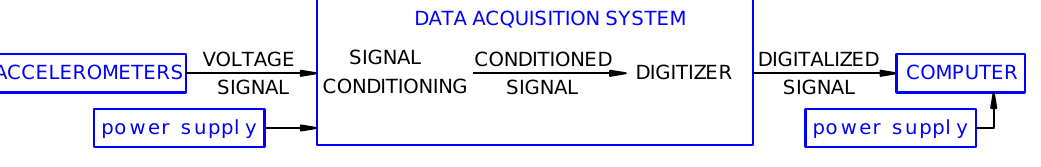
Figure 4. Data acquisition process.